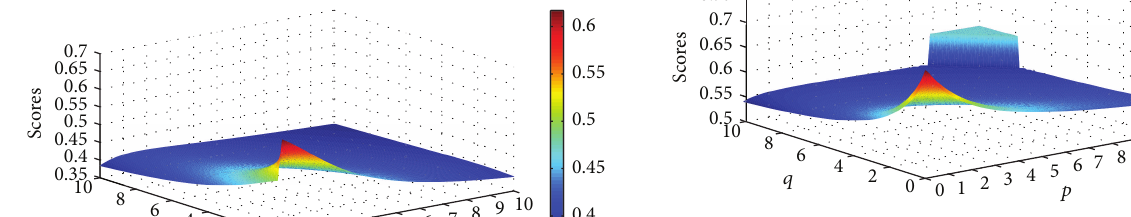
Figure 7: Scores for District 𝐴 3 obtained by the IIFGWHM operator ( 𝑝 ∈ (0,6], 𝑞 ∈ (0, 6] ).